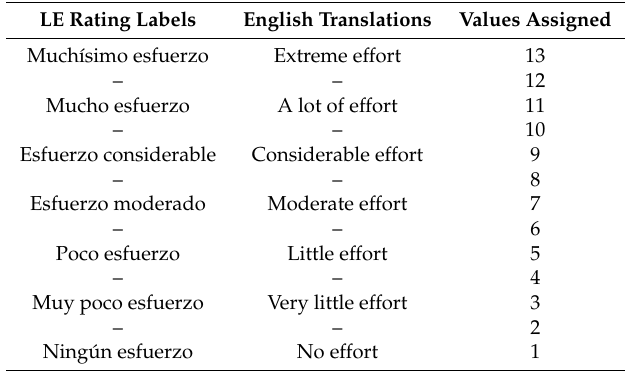
Table 2. LE rating labels, their English translations, and the values